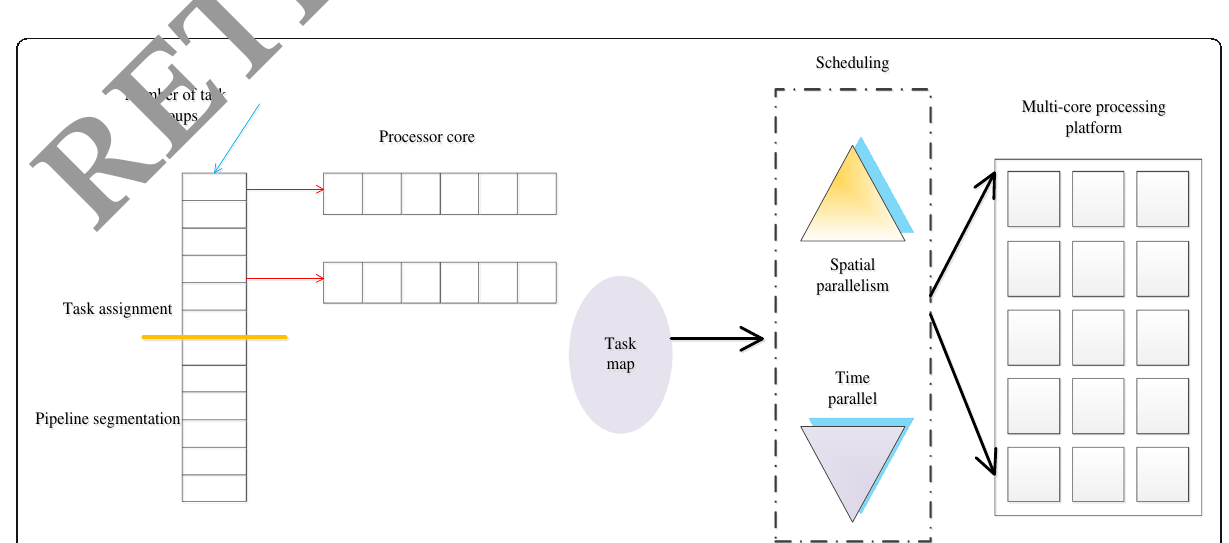
Fig. 1 Task scheduling for multicore